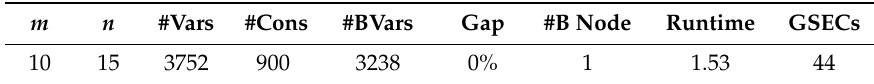
Table 8. Test results of